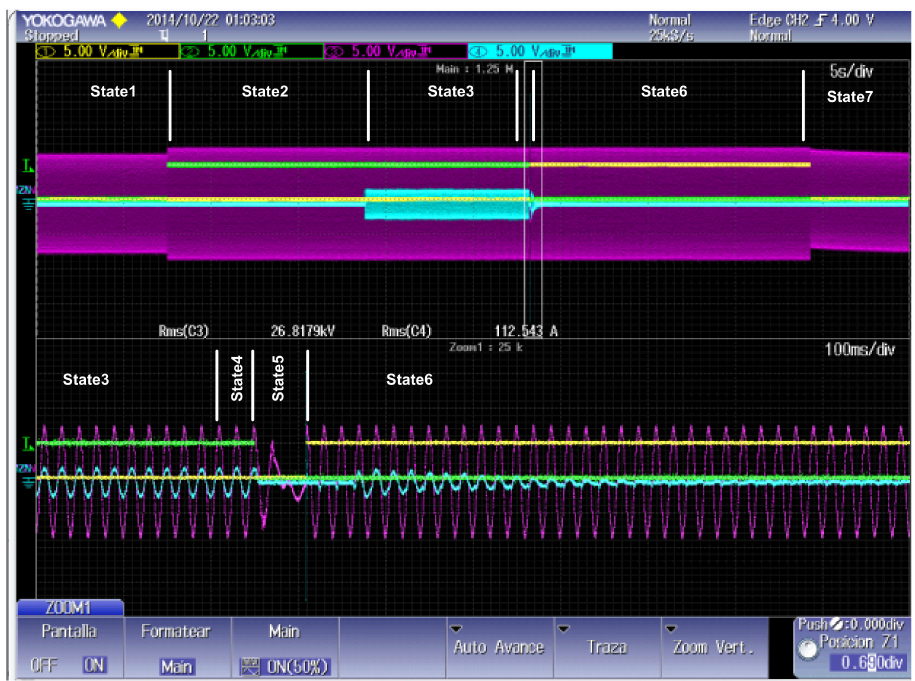
Figure 10. HST travelling at 300 km/h from section 2 to section 1. Ch1, S1 command; Ch2, S2 command; Ch3, NS voltage; Ch4, NS